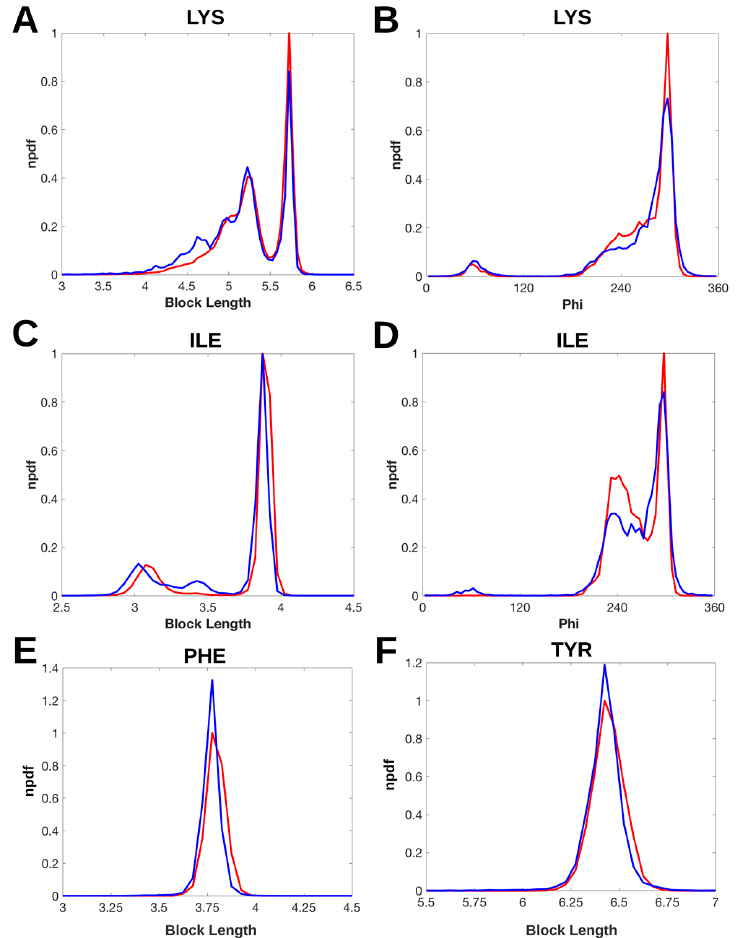
Figure 2. Normalized probability density function of block length and torsion angle φ . The distribution of block length and φ is shown respectively as a probability density function (npdf) normalized by the highest peak of the pdf of the X-ray-1.5 data set. The npdf of X-ray-1.5 data set (red line) and the npdf of EM-2-4 data set (blue line) are shown for lysine (LYS) ( A , B ); isoleucine (ILE) ( C , D ); phenylalanine (PHE) ( E ); and tyrosine (TYR) ( F ) respectively.